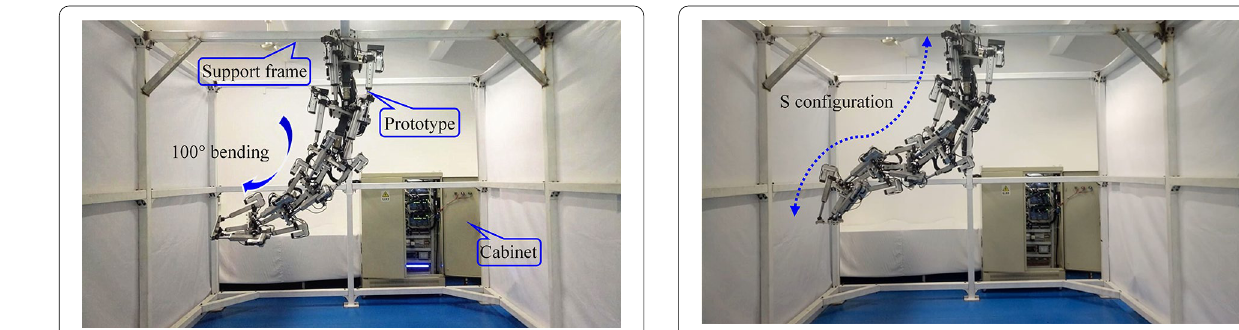
Figure 23 S configuration of HRETR